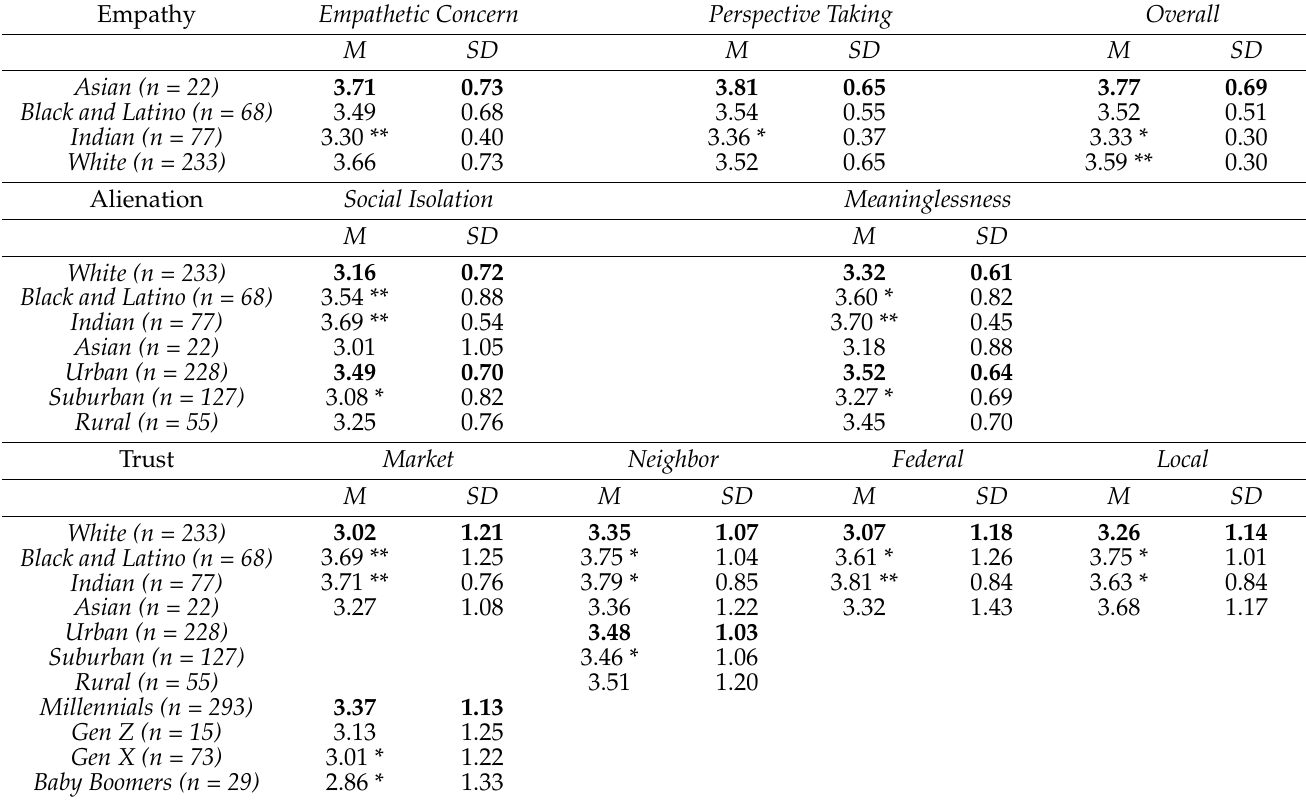
Table 5. Means for Ethnicity, Region, and Generation and Dependent